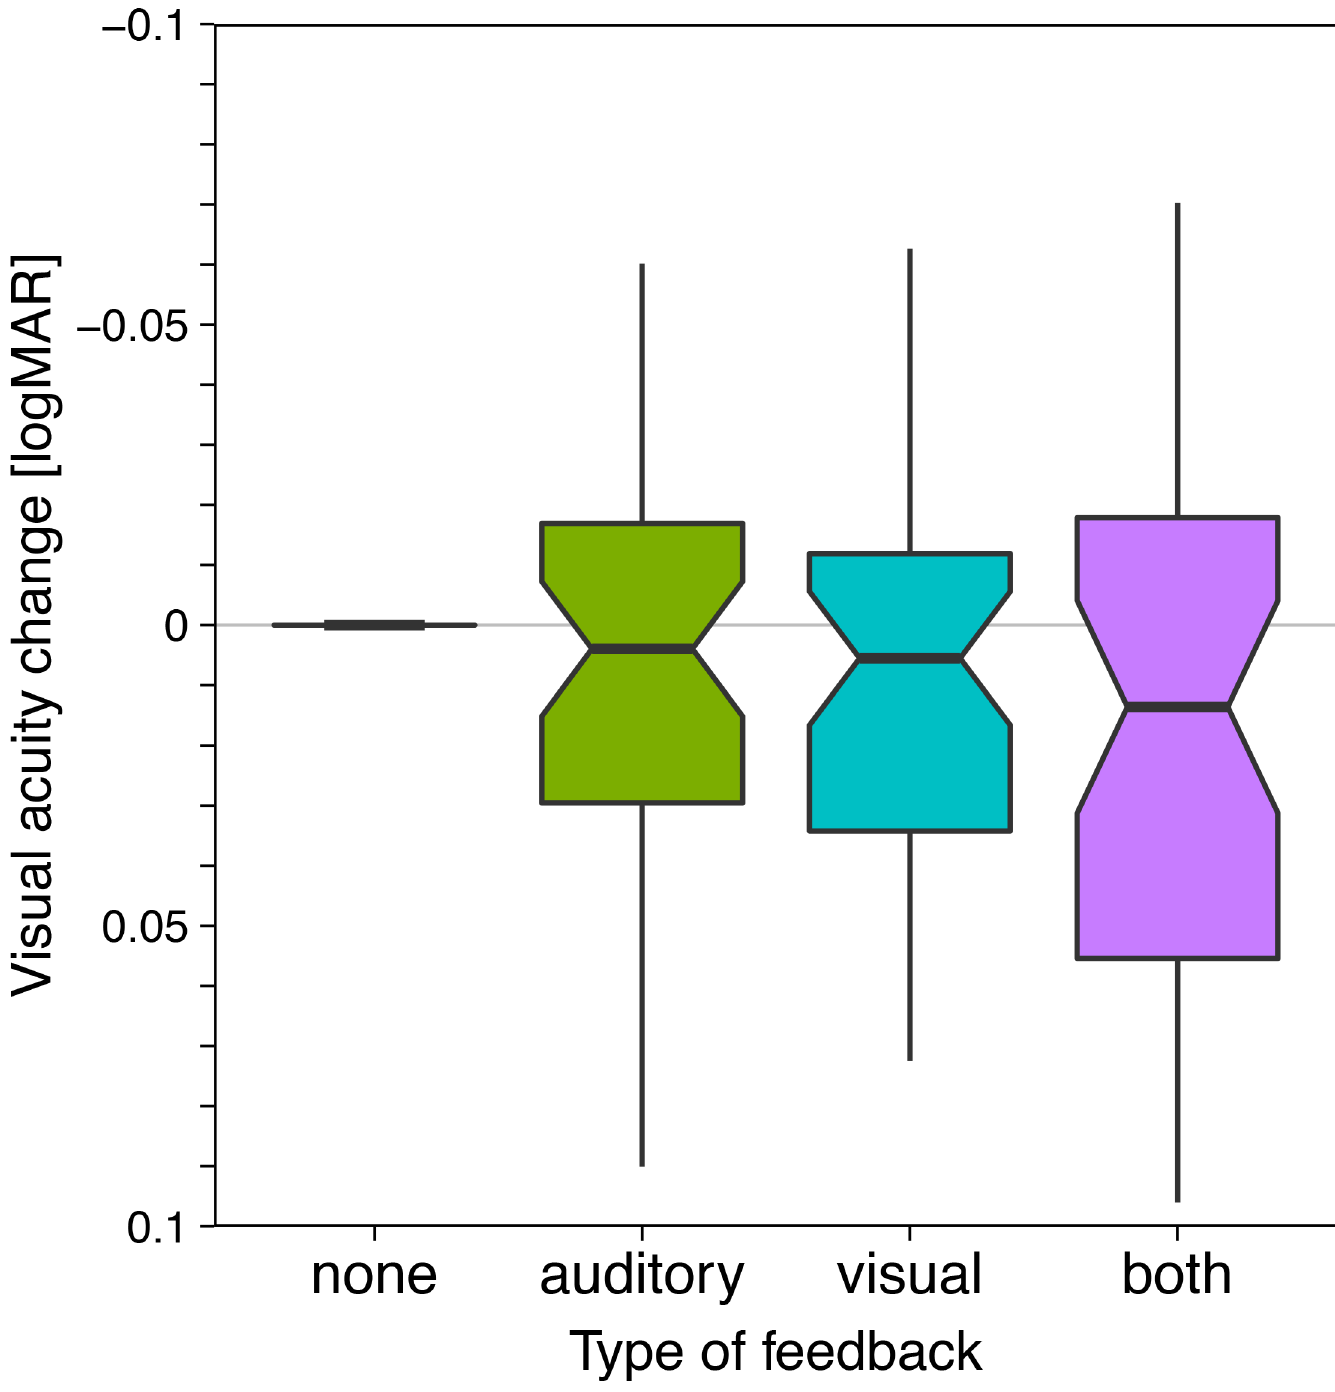
Fig 3. Acuity results across the four different feedback conditions. Details as in Fig 2, but here the values are normalized with respect to the “ none ” condition, allowing scale expansion. Note that for the “ both ” condition, slightly lower acuity resulted; the small difference of 0.02 logMAR is, however, clinically